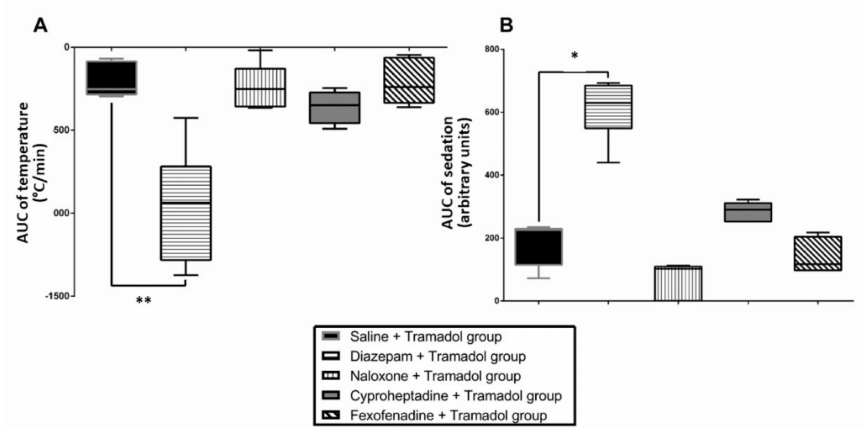
Figure 1. Effects on sedation ( A ) and temperature ( B ) of intraperitoneal (i.p.) 75 mg/kg tramadol administration (T0) in Sprague-Dawley rats pretreated with i.p. 4% tween at T-15 + intravenous (i.v.) saline at T-10 (Saline + Tramadol group, black); i.p. 1.77 mg/kg diazepam at T-15 + i.v. saline at T-10 (Diazepam + Tramadol group, horizontal lines); i.p. 4% tween at T-15 + i.v. 2 mg/kg bolus followed by 4 mg/kg/h naloxone at T-10 (Naloxone + Tramadol group, vertical lines); i.p. 10 mg/kg cyproheptadine at T-15 + i.v. saline at T-10 (Cyproheptadine + Tramadol group, grey); and i.p. 15 mg/kg fexofenadine at T-30 + i.v. saline at T-10 (Fexofenadine + Tramadol group, diagonal lines). Results are expressed as median and quartiles (N = 6/group). * p < 0.05, ** p < 0.01. Diazepam completely abolished seizures in tramadol-treated rats, whereas naloxone, cyproheptadine and fexofenadine pretreatments had no significant effects on